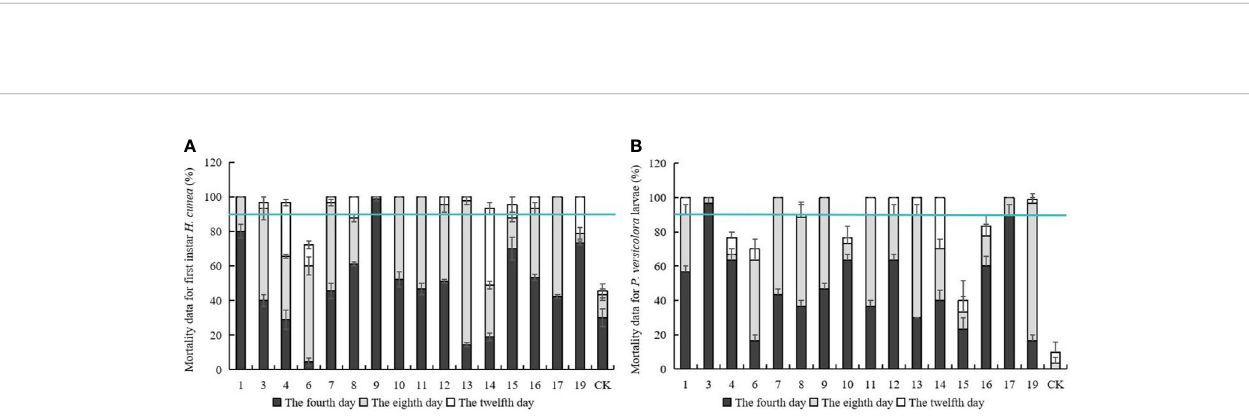
FIGURE 2 | A comparison of leaves from transgenic and non-transgenic lines after 2 days of larval feeding. (A) Feeding status of H. cunea on non-transgenic leaves. (B) Feeding status of H. cunea on transgenic leaves. (C) Feeding status of P. versicolora on non-transgenic leaves. (D) Feeding status of P. versicolora on transgenic leaves.